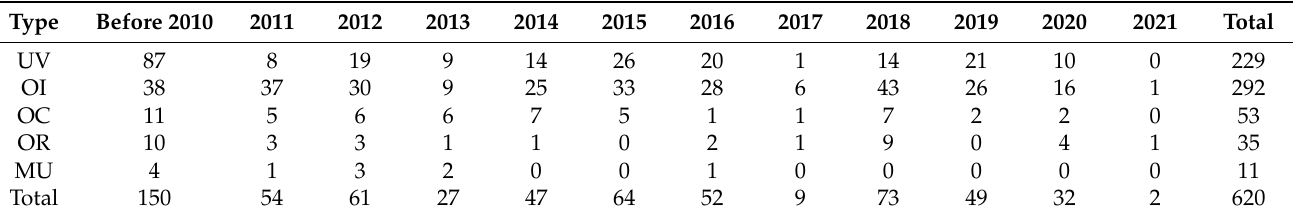
Table 4. Development of UR projects in each